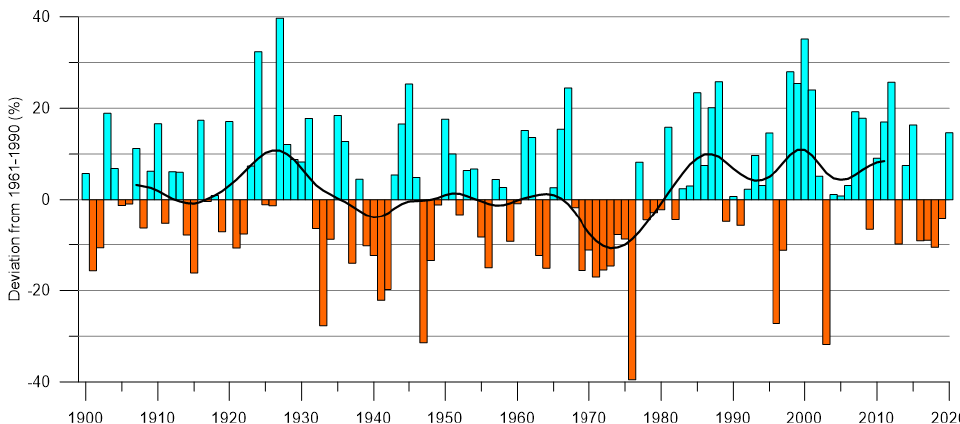
Figure 10. Area-weighted river runoff anomalies relative to 1960–1990 (in percent) from Sweden to the Baltic Sea. The black solid curve denotes Gaussian filtered data with a standard deviation of 3 years. Data source: https://www.smhi.se (last access: 5 March